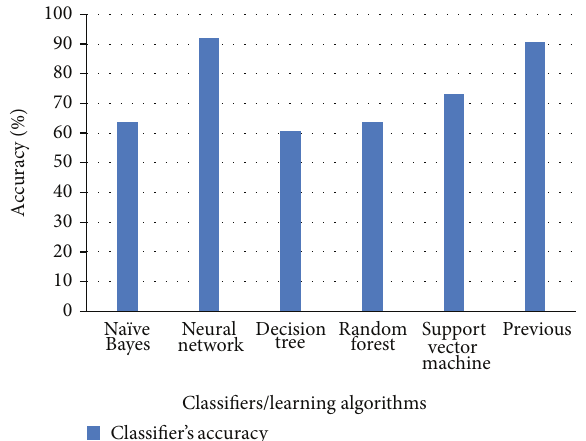
Figure 8: Comparison of each classifier’s classification accuracy using dataset 3.